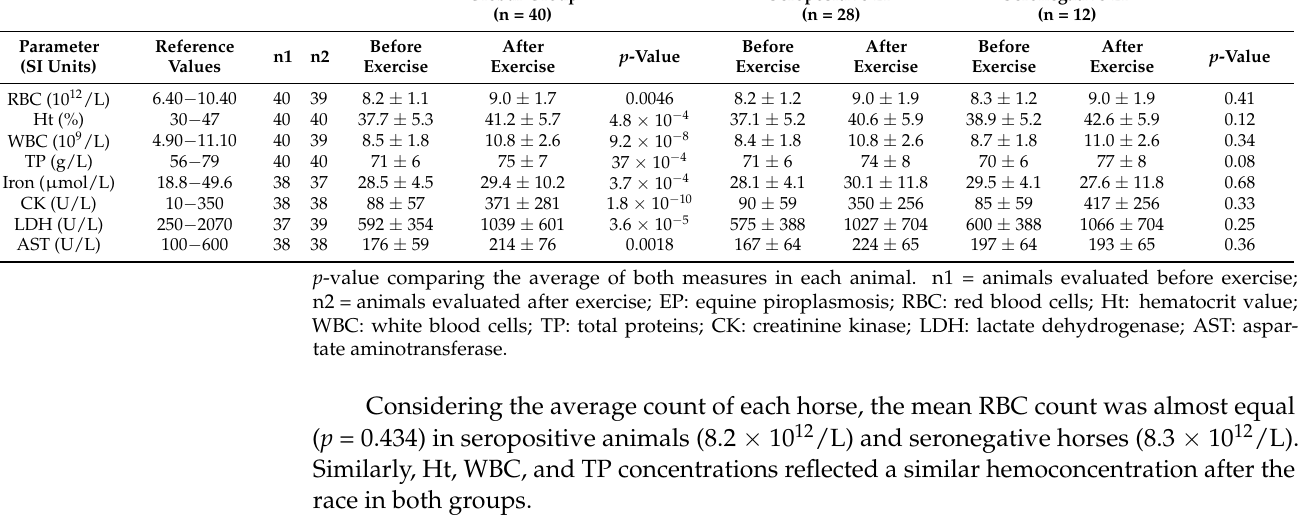
Table 1. Summary of mean ± standard deviation (SD) of hematologic and biochemistry parameters values depending on the presence of equine piroplasmosis (EP) and performance of the exercise.